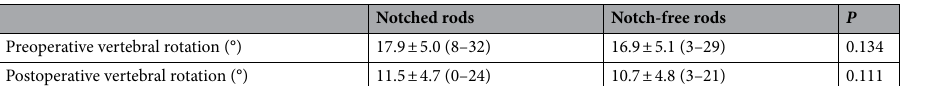
Table 3. Vertebral rotation angle of main thoracic apical vertebra. All data expressed as means ± SD and range. Mann–Whitney U test.